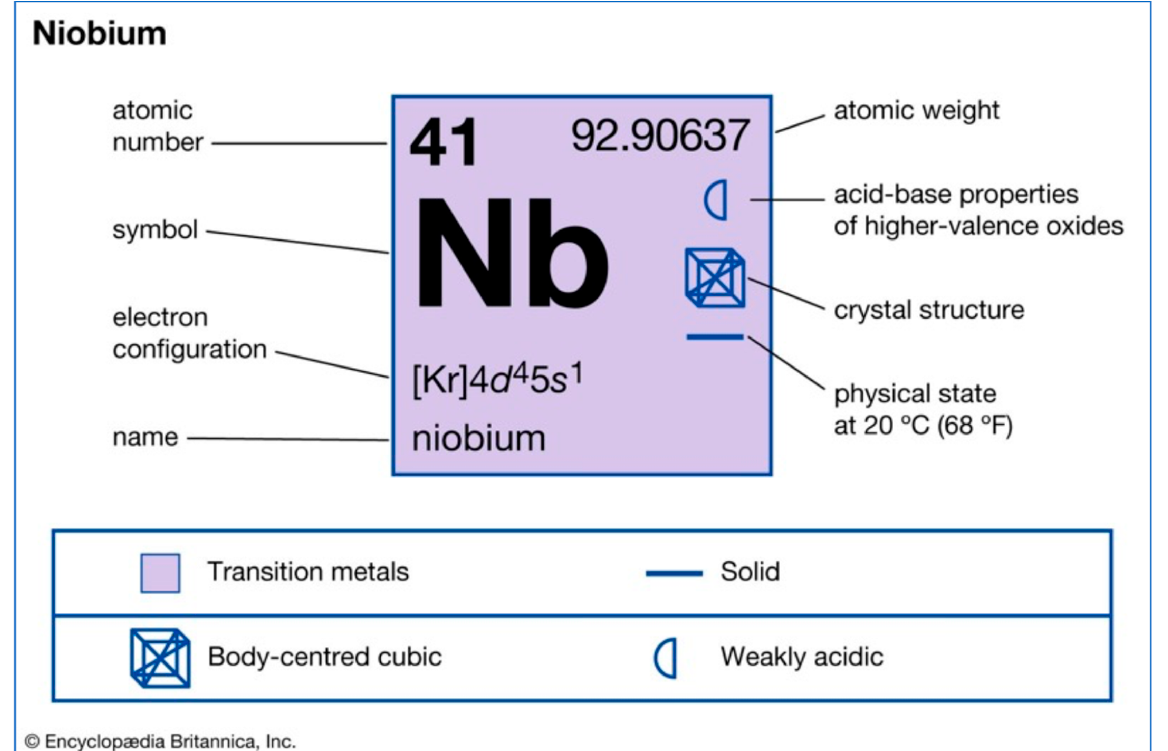
Figure 1. Characteristics of the element niobium.